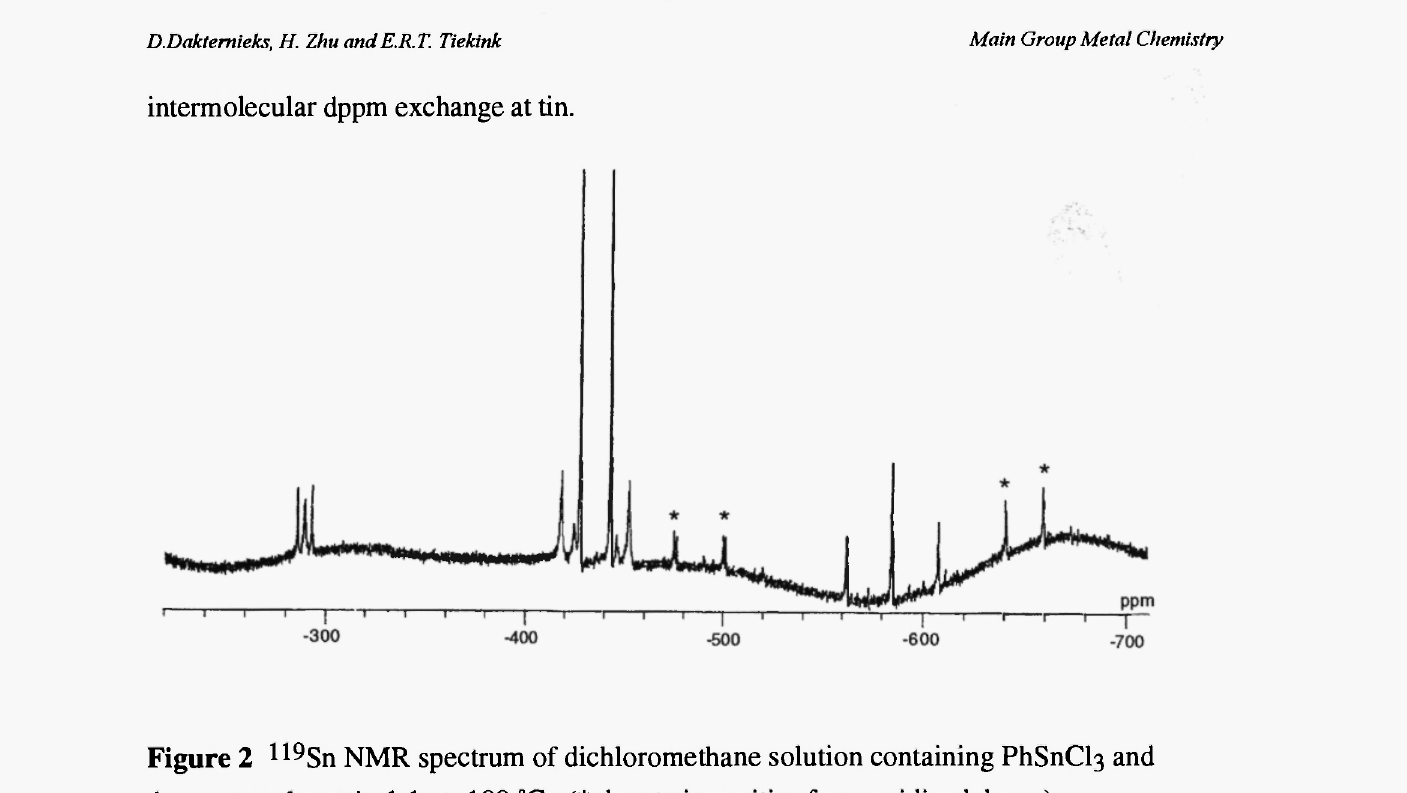
Figure 2 119 Sn NMR spectrum of dichlororaethane solution containing PhSnClß and dppm at molar ratio 1:1 at -100 °C. (* denote impurities from oxidized